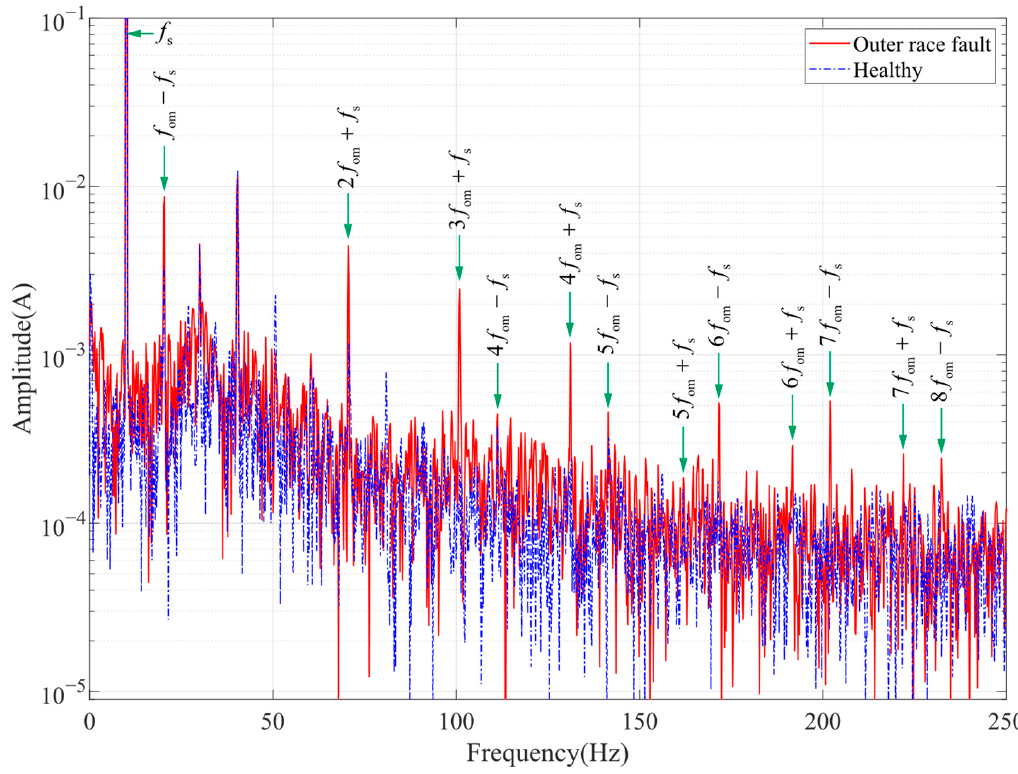
Figure 14. Comparison of stator current simulation signal spectrum under outer race fault (10 Hz).